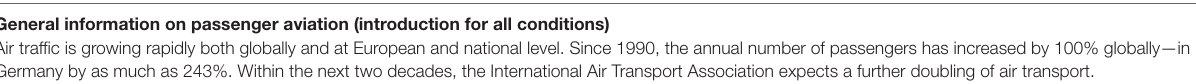
TABLE 1 | Information provided in the three experimental conditions and the control